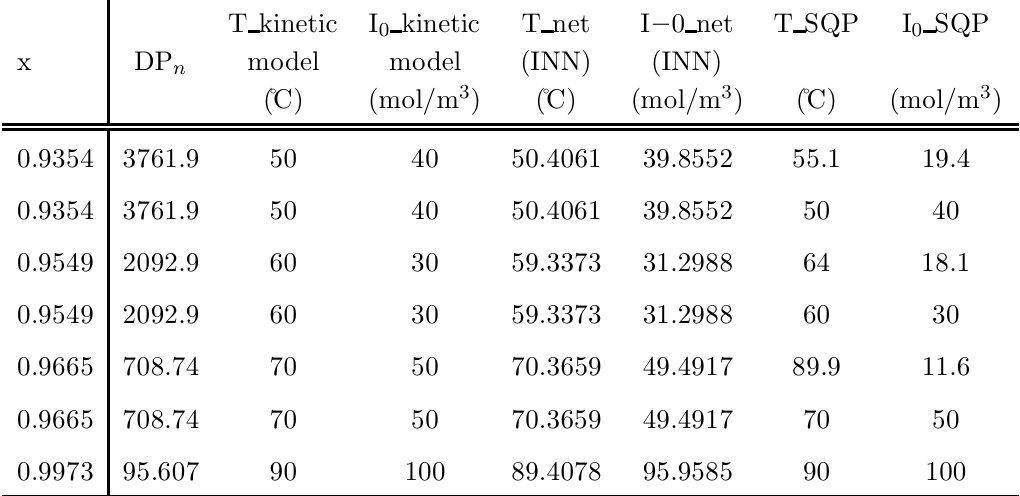
Table 1 Comparison between optimization results obtained with SQP and INN